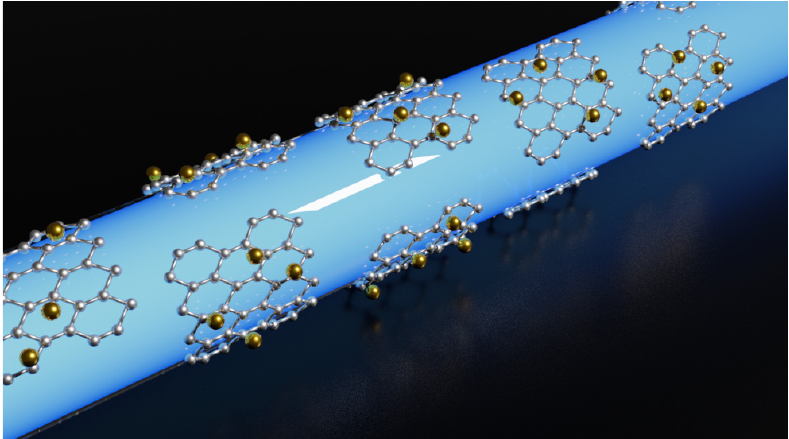
Figure 1. Artistic impression of microfiber with a protective overlayer of a composite of graphene and gold